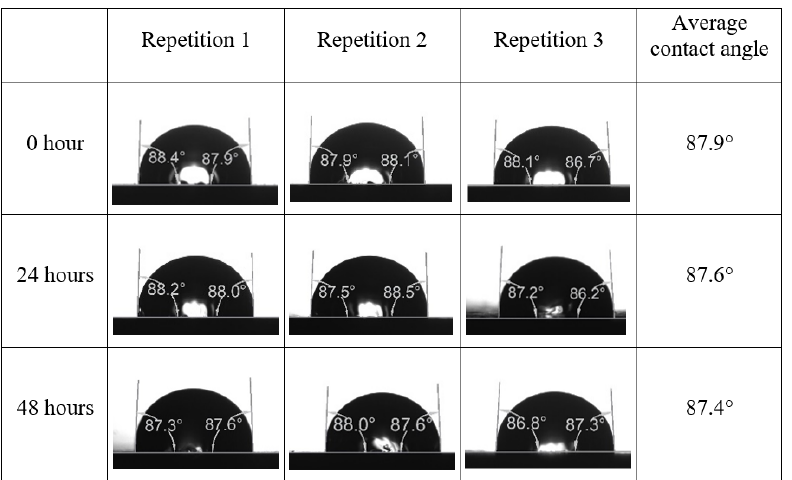
Figure A23. Dynamic Contact Angle Measurement Results for 25% Na 2 SO 4 + 75% NaCl (3500